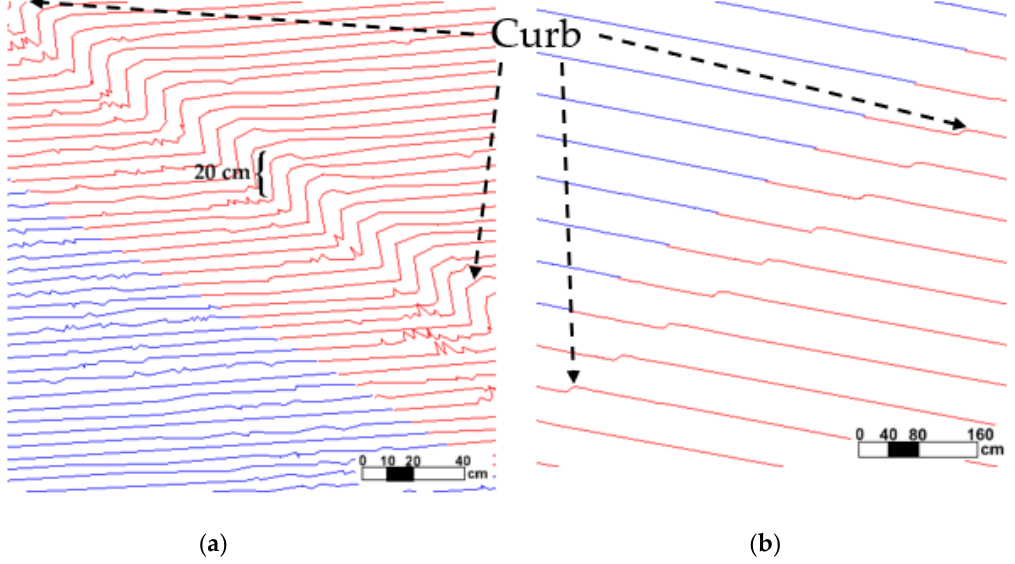
Figure 4. TCS intersection with the curb sudden terrain change effect: ( a ) isometric trajectory view and ( b ) terrain top view. perspective view and ( b ) terrain top view.